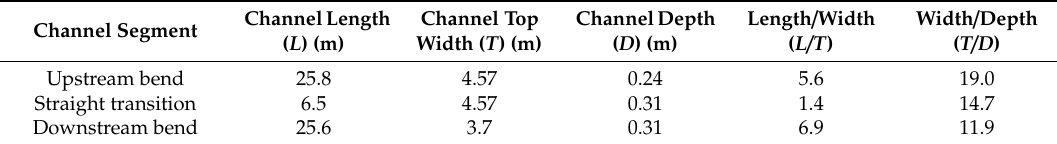
Table 3. CSU physical model dimensions. Table 4. Finest numerical model mesh size used to simulate the flow through the CSU physical model ( i , j , and k were the model mesh sizes in the longitudinal, transverse, and vertical dimensions, respectively; L , T , and D were the channel dimensions of length, top width, and depth,